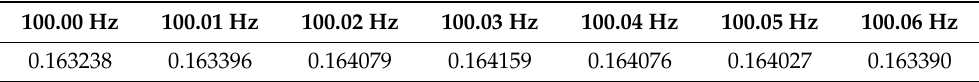
Table 3. The KPE distribution of IMF8 under different driving force frequencies.